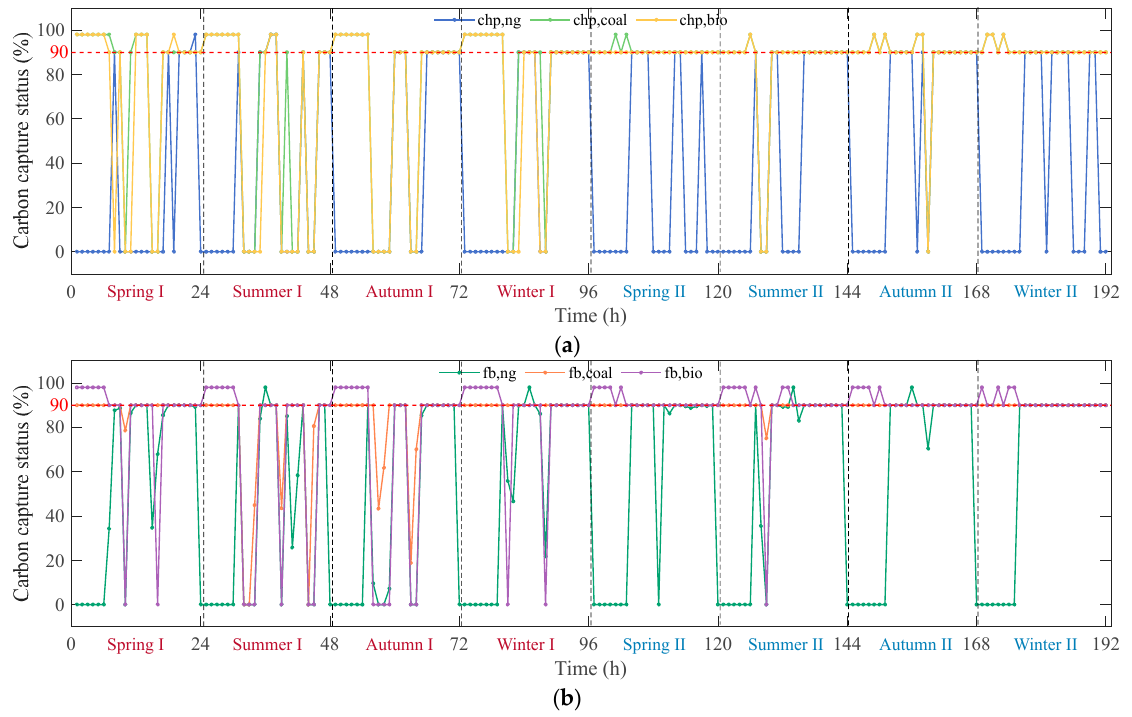
Figure 11. State of Oxygen-Enriched Combustion and Carbon Capture of CHP and FB in Two Stages of Case 1: ( a ) CHP; ( b ) FB.